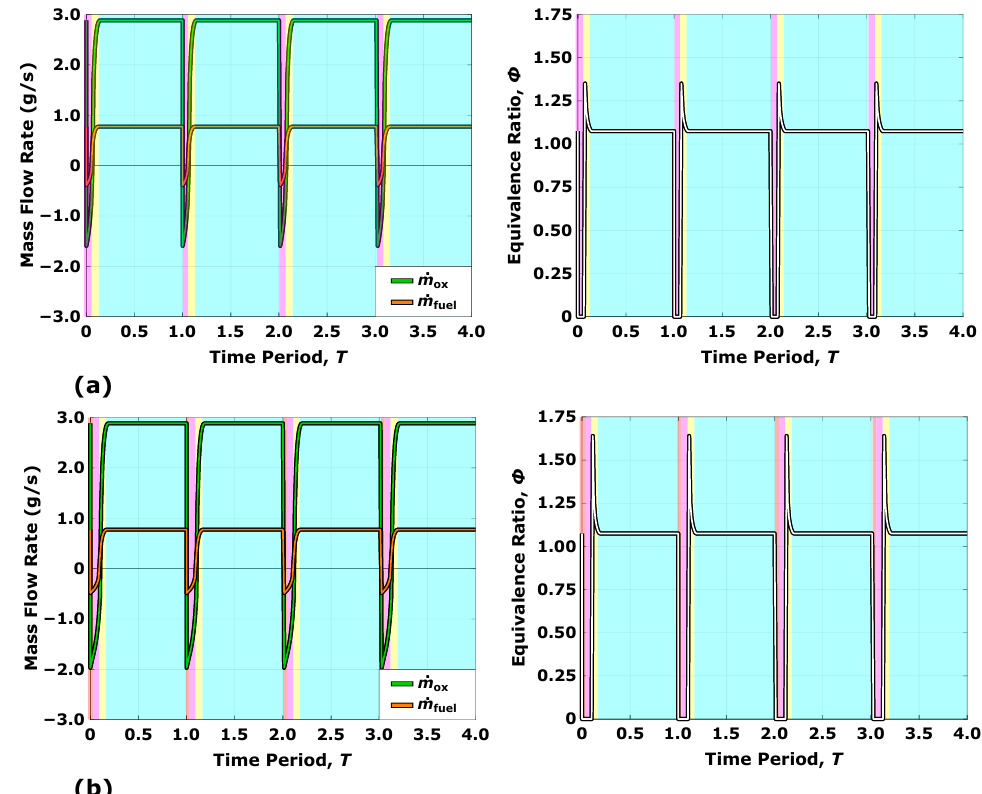
Figure 22. Temporal histories for the fuel and oxidizer mass flow rate ( left ) and corresponding equivalence ratio φ ( right ), for the ( a ) p rise = 20 and ( b ) p rise = 30 cases. Note that the cyan highlighted periods denote choked flow, yellow corresponds to unchoked flow, whereas red and magenta are reversed choked and unchoked flow,